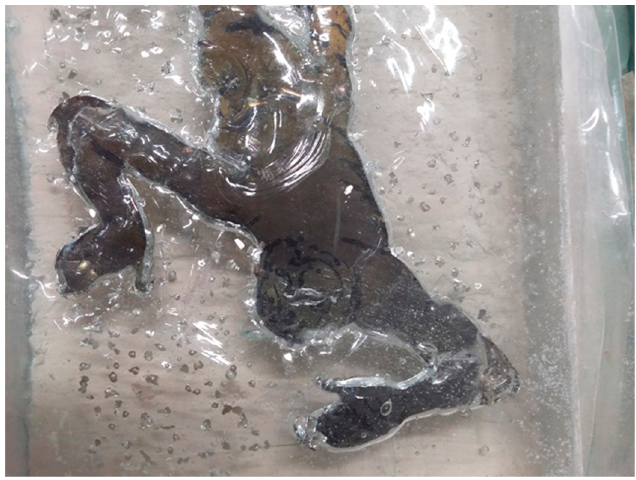
Figure 7. The metal/glass bond caused stress during the cooling process; created by author.